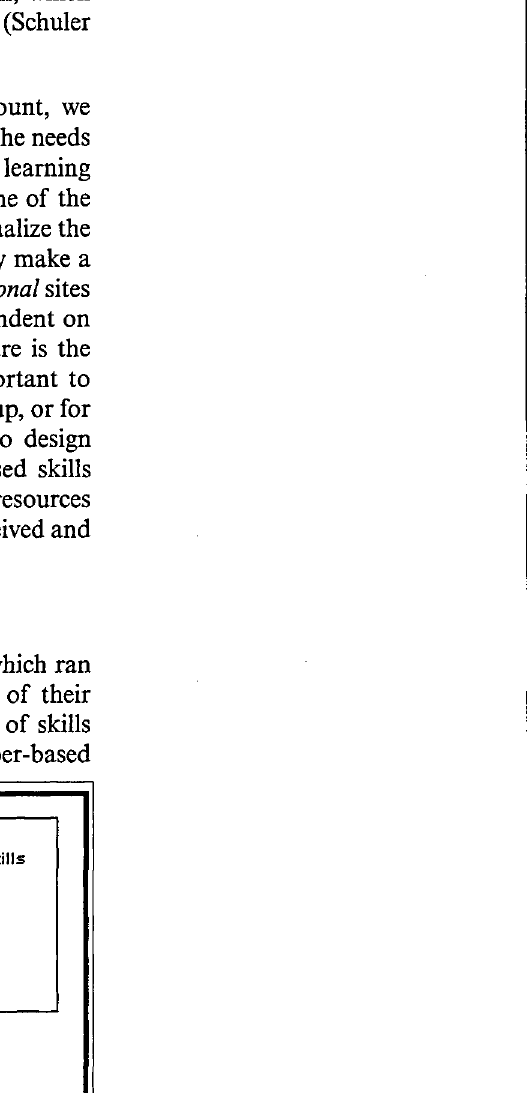
Figure I: Model of the UCL key skills